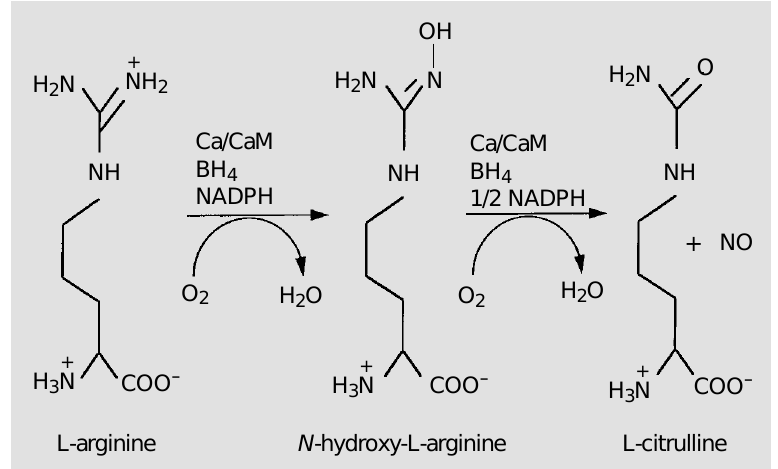
Figure 4 - The nitric oxide synthetic pathway. NADPH, Nicotinamide adenine dinucleotide phosphate.